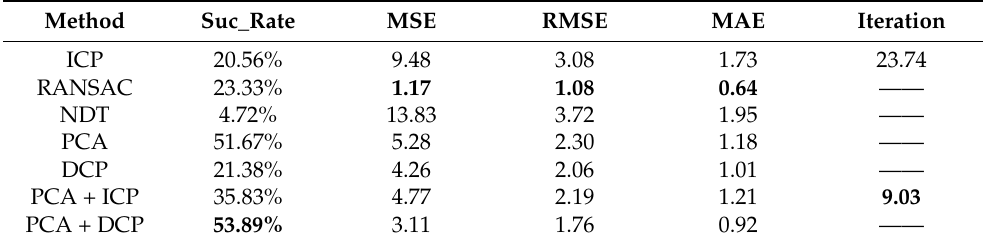
Table 3. Registration results of different